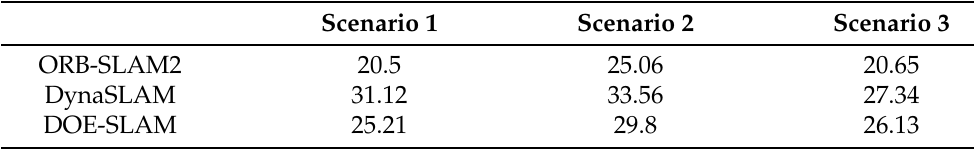
Table 2. Comparison of the average computation time (ms).